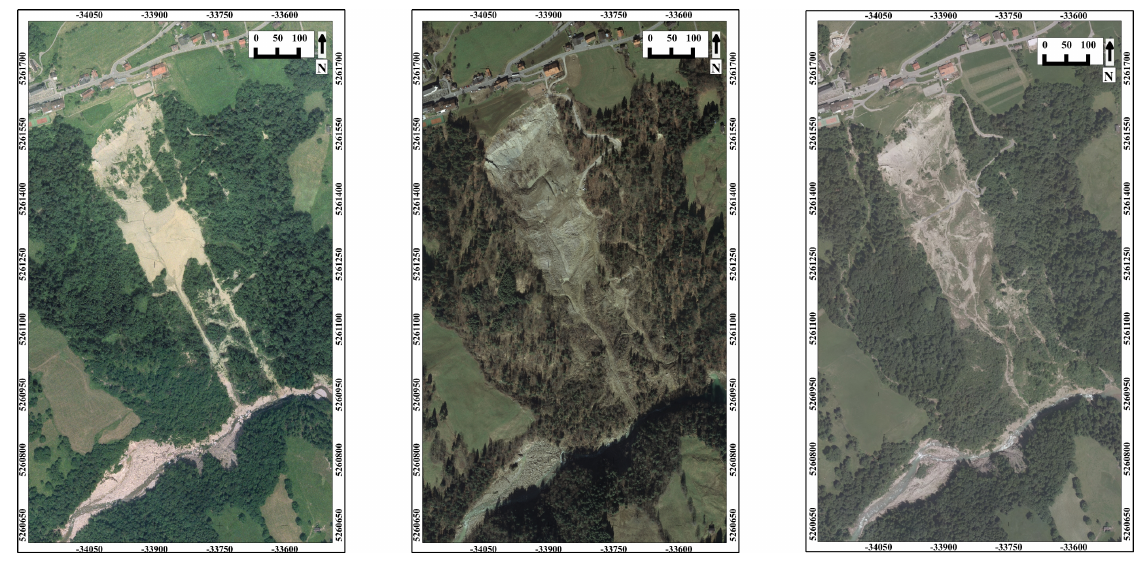
Figure 7. Orthophotos of the landslide area from year ( Left ) 2006, ( Middle ) 2007 and ( Right ) 2012.